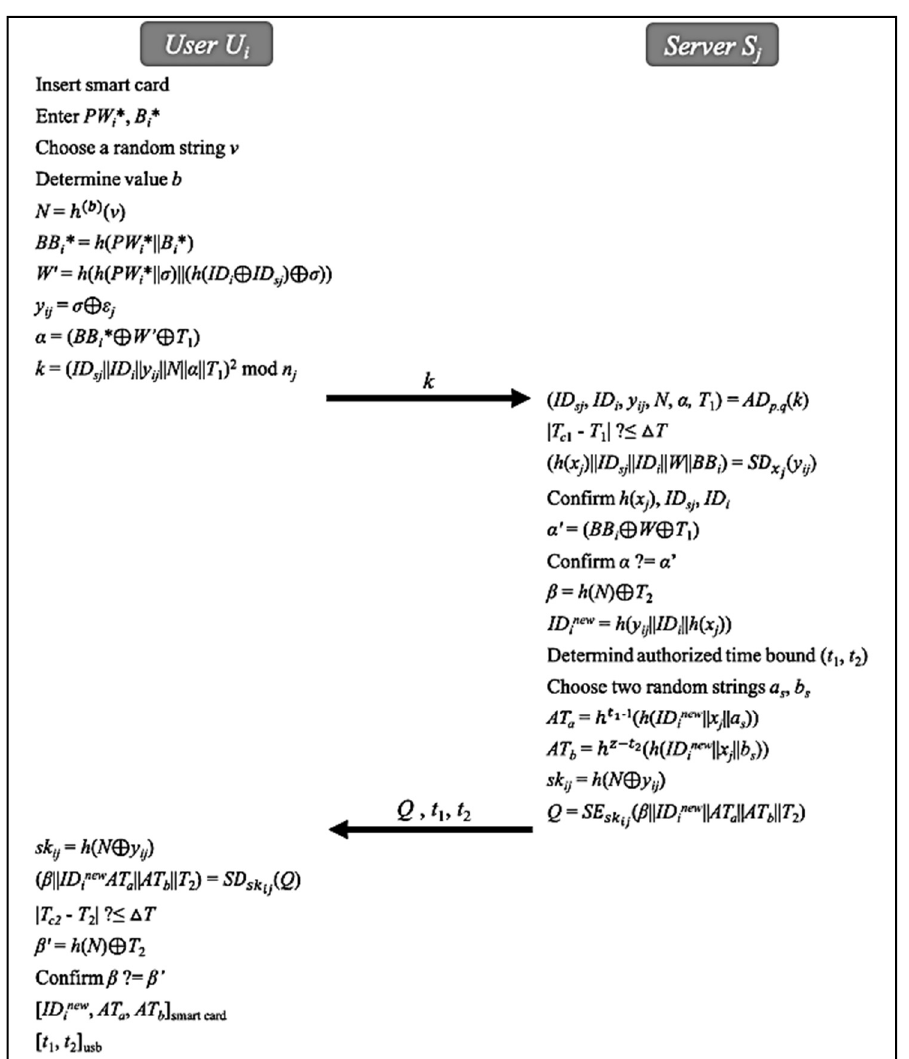
Figure 4. Login and initial authentication phase.